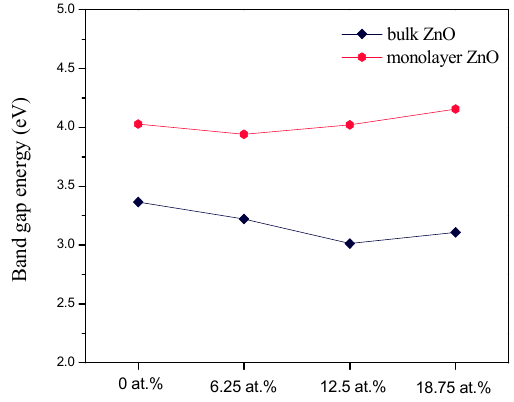
Figure 4. The band gap of Al-doped ZnO bulk and monolayer.